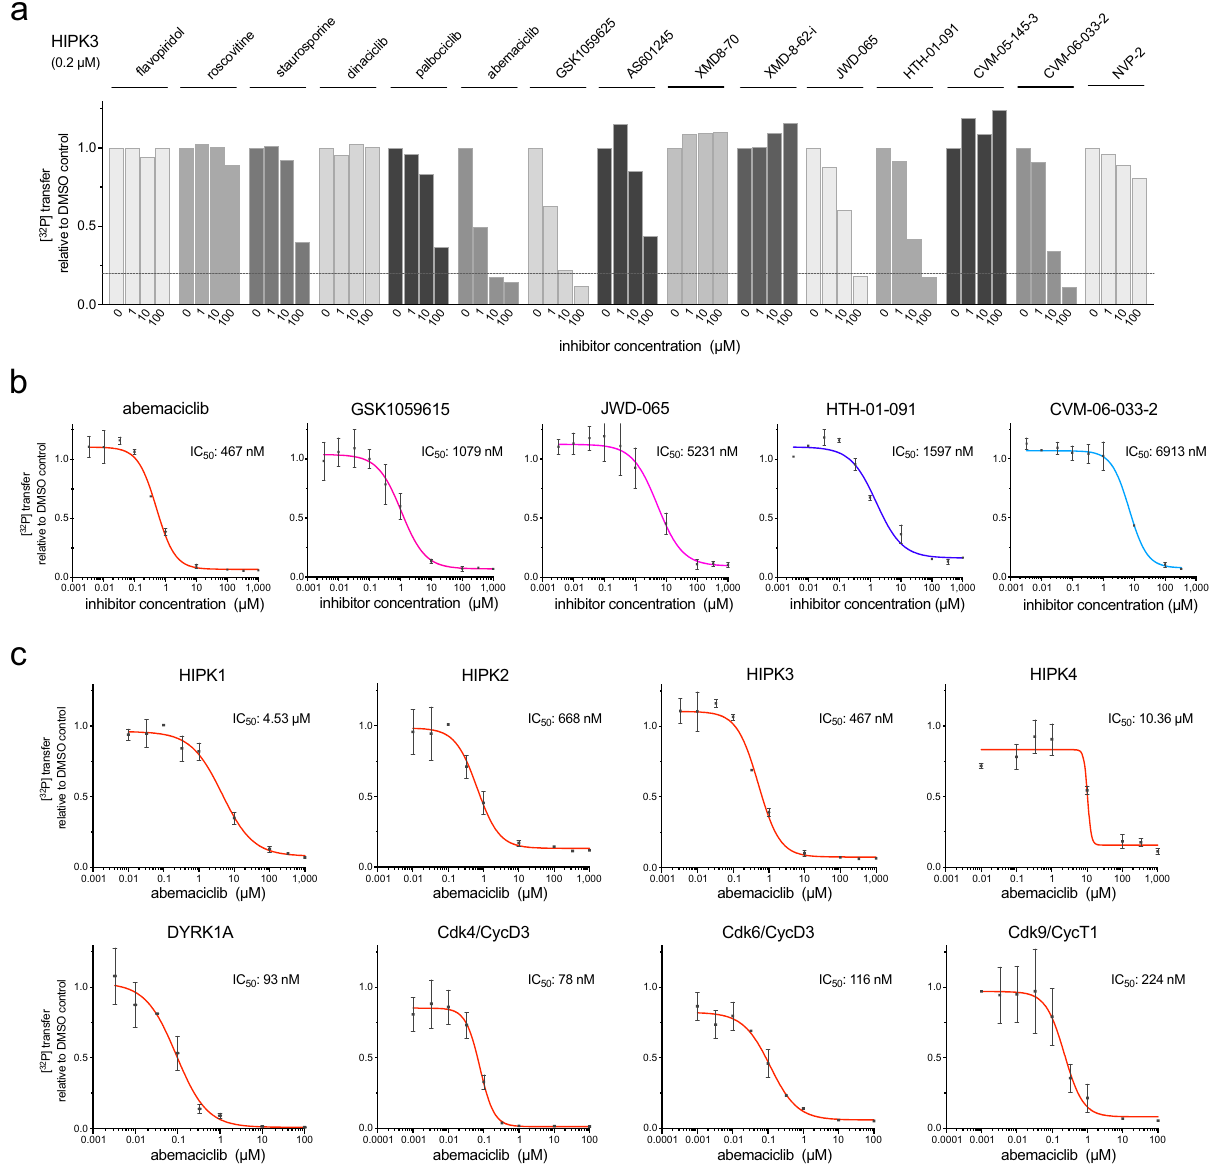
Fig. 6 Abemaciclib is a potent inhibitor of HIPK2, HIPK3, and DYRK1A. a A panel of 15 small-molecule inhibitors was tested at 1, 10, and 100 μ M concentration for the inhibition of HIPK3 using radioactive kinase activity assays. Compounds were preincubated for 5 min with 0.2 μ M kinase and 0.2 mM